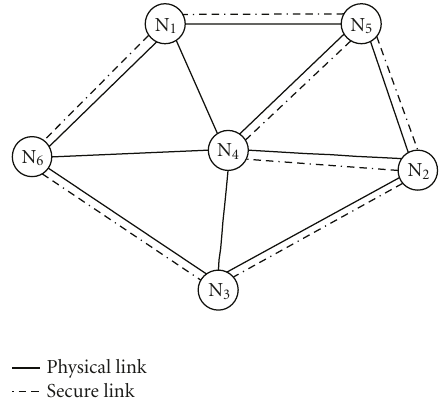
Figure 1: Path key establishment